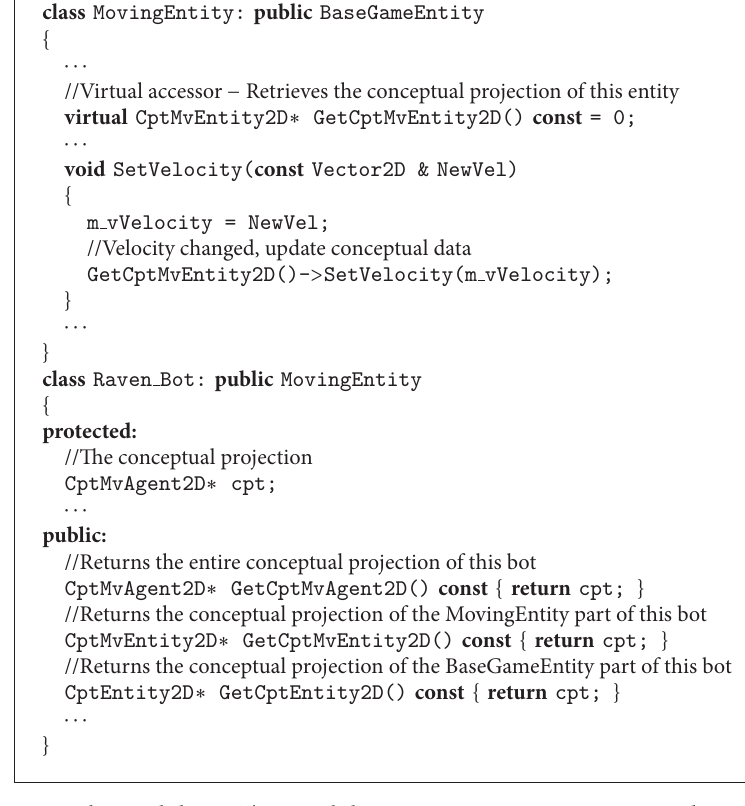
Algorithm 12: Synchronization with virtual classes. The virtual class MovingEntity uses a pure virtual getter implemented by its concrete subclass Raven Bot for its synchronization code.